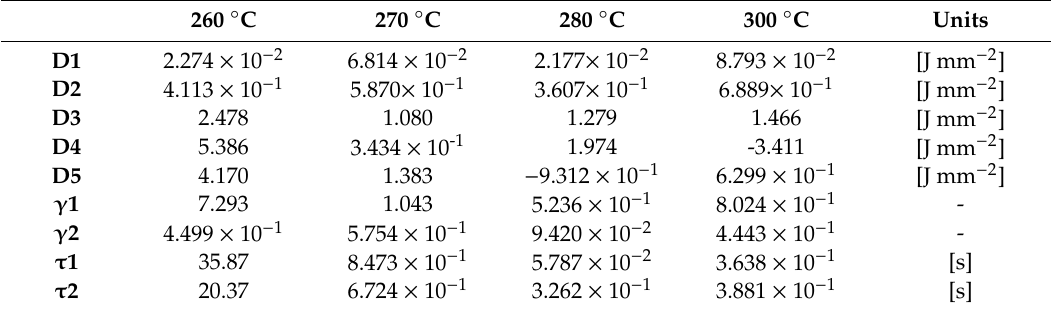
Figure 6. Comparison between experimental and optimal results for a 2 × 2 twill in carbon/PA 6-6 prepregs. Table 2. Optimized parameters related to consolidation deformation at different temperatures.